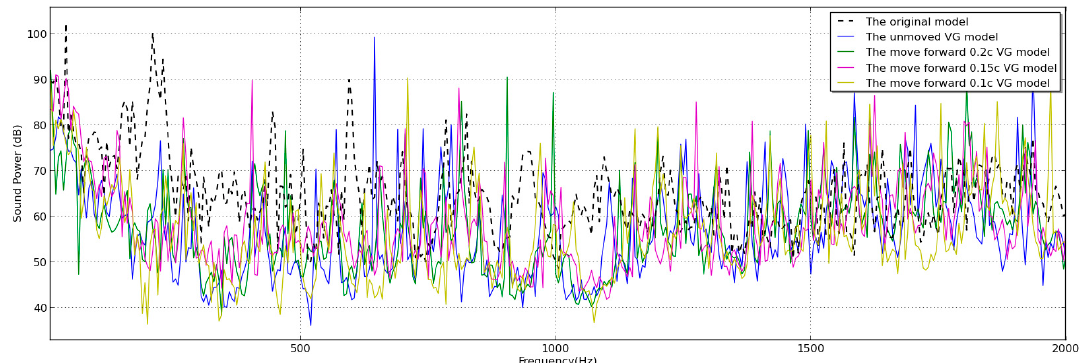
Figure 22. The comparison curve of radiated sound power from the original model and the models with triangular VGs at different distances. The black line denotes the radiated sound power from the original model. The blue dot line denotes the radiated sound power from the model with triangular VGs at the leading edge of the sail hull. The green line denotes the radiated sound power from the model with triangular VGs at a distance of 0.2c from the leading edge of the sail hull. The pink line denotes the radiated sound power from the model with triangular VGs at a distance of 0.15c from the leading edge of the sail hull. The yellow line denotes the radiated sound power from the model with triangular VGs at a distance of 0.1c from the leading edge of the sail hull.